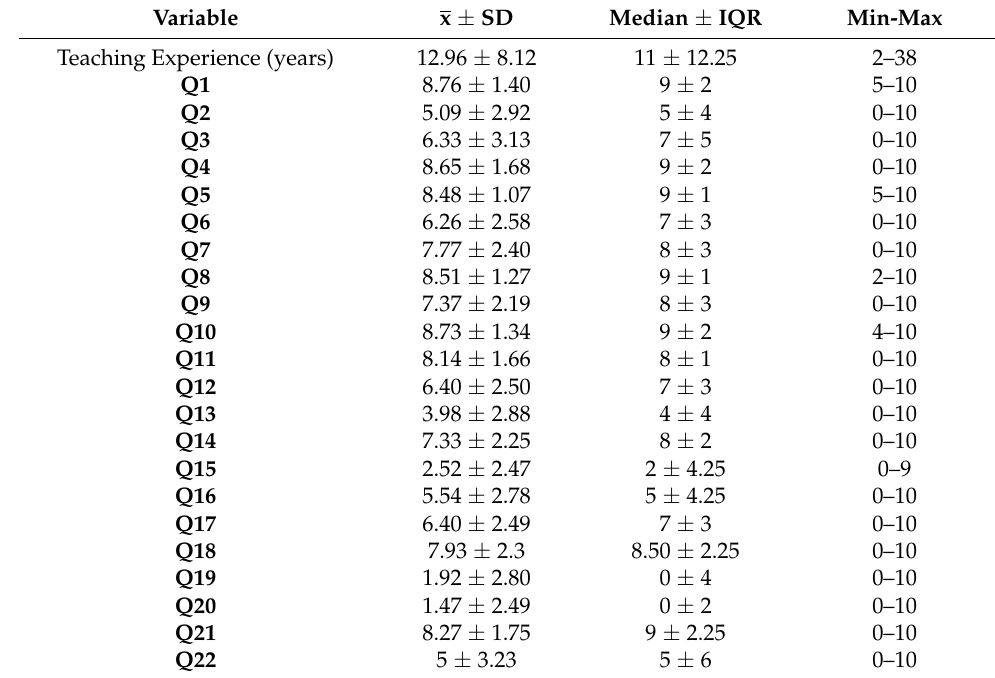
Table 2. Descriptive statistics of the questionnaire